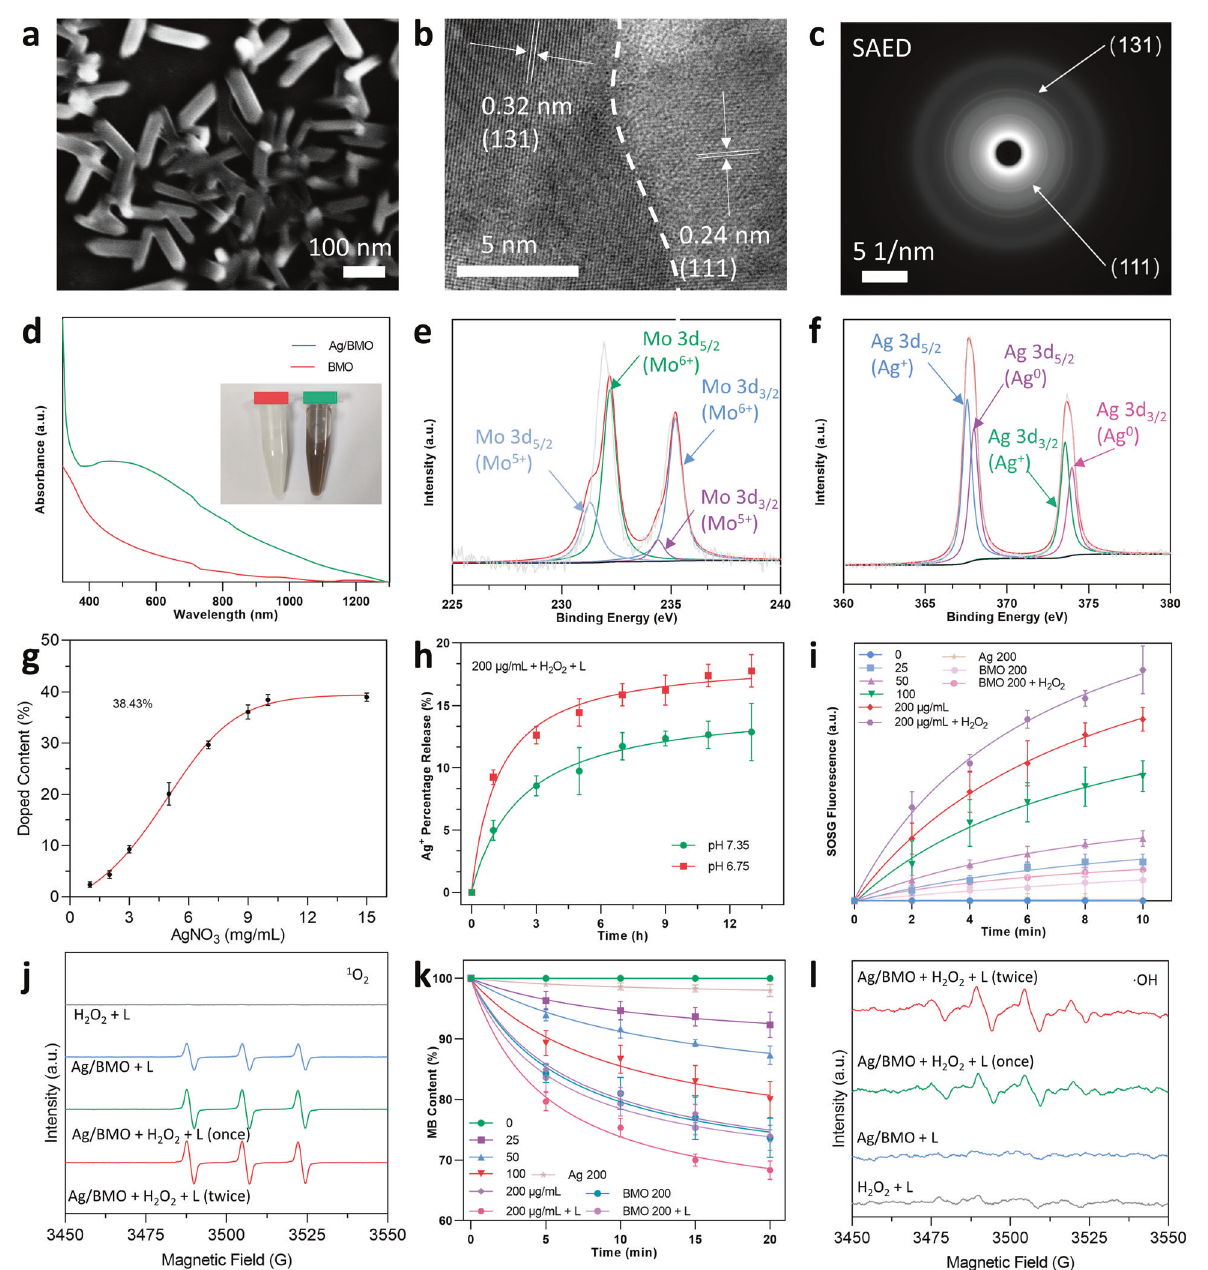
images of Ag/BMO NPs. d UV-vis absorption of BMO and Ag/BMO NPs solution in water. e , f XPS spectra of Mo 3d and Ag 3d. g Doping content of Ag NPs (The concentration of AgNO 3 is ranging from 1 to 15 mg L − 1 ). h Percentage release of Ag + at pH 7.35 and pH 6.75. i The 1 O 2 detection using SOSG probe. j ESR spectra of 1 O 2 . k The ·OH detection using MB indicator. I ESR spectra of